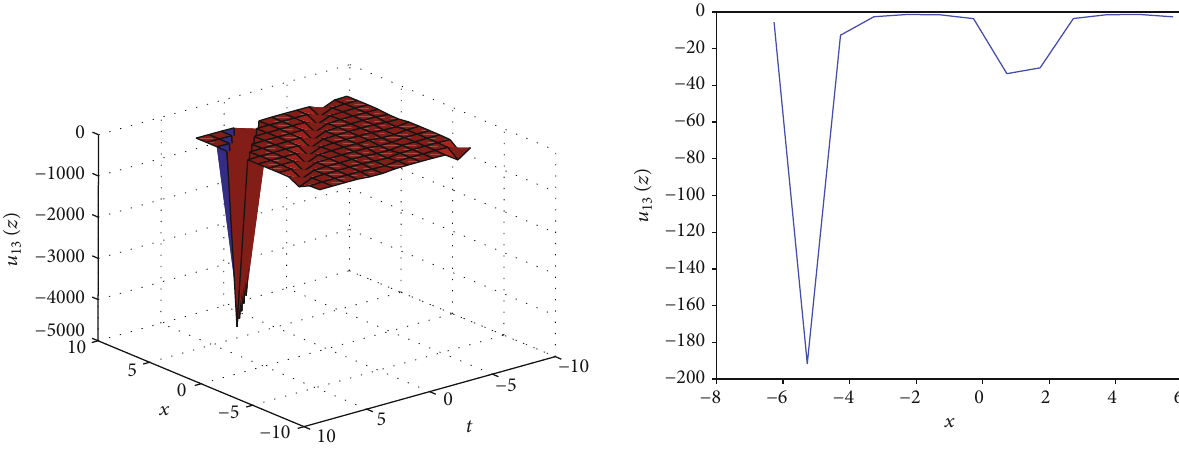
ð z Þ by choosing the values γ = 4 , ϑ = 5 , λ = 1 , ω = 1 , c = 1 , and t = 0 for the 2D Figure 3: The 3D and 2D graphics of u 13